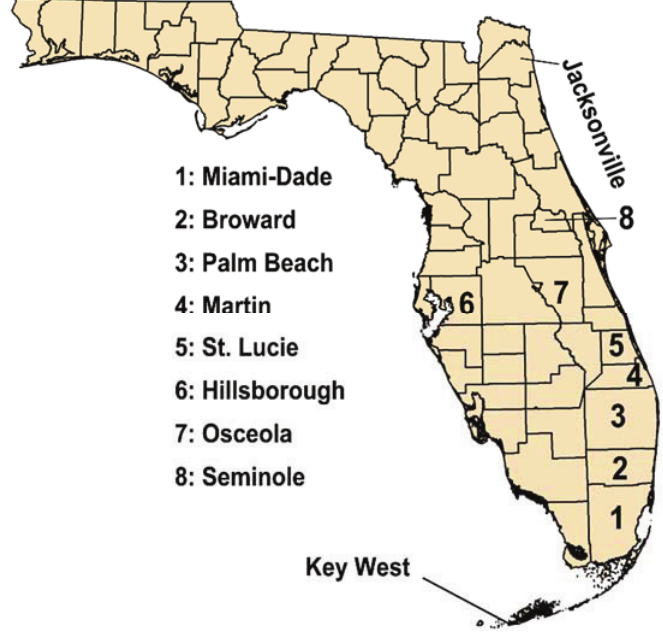
Figure 2. Map of Florida showing key locations discussed in the text (not to